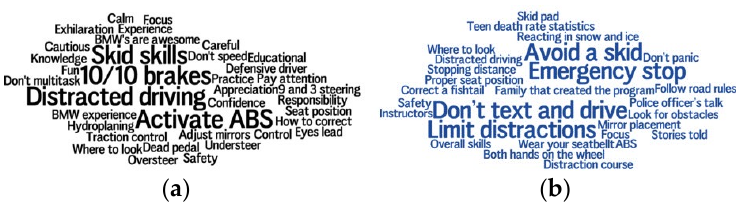
Figure 4. Word cloud of the top five things from the program: survey ( a ) and interview ( b ).